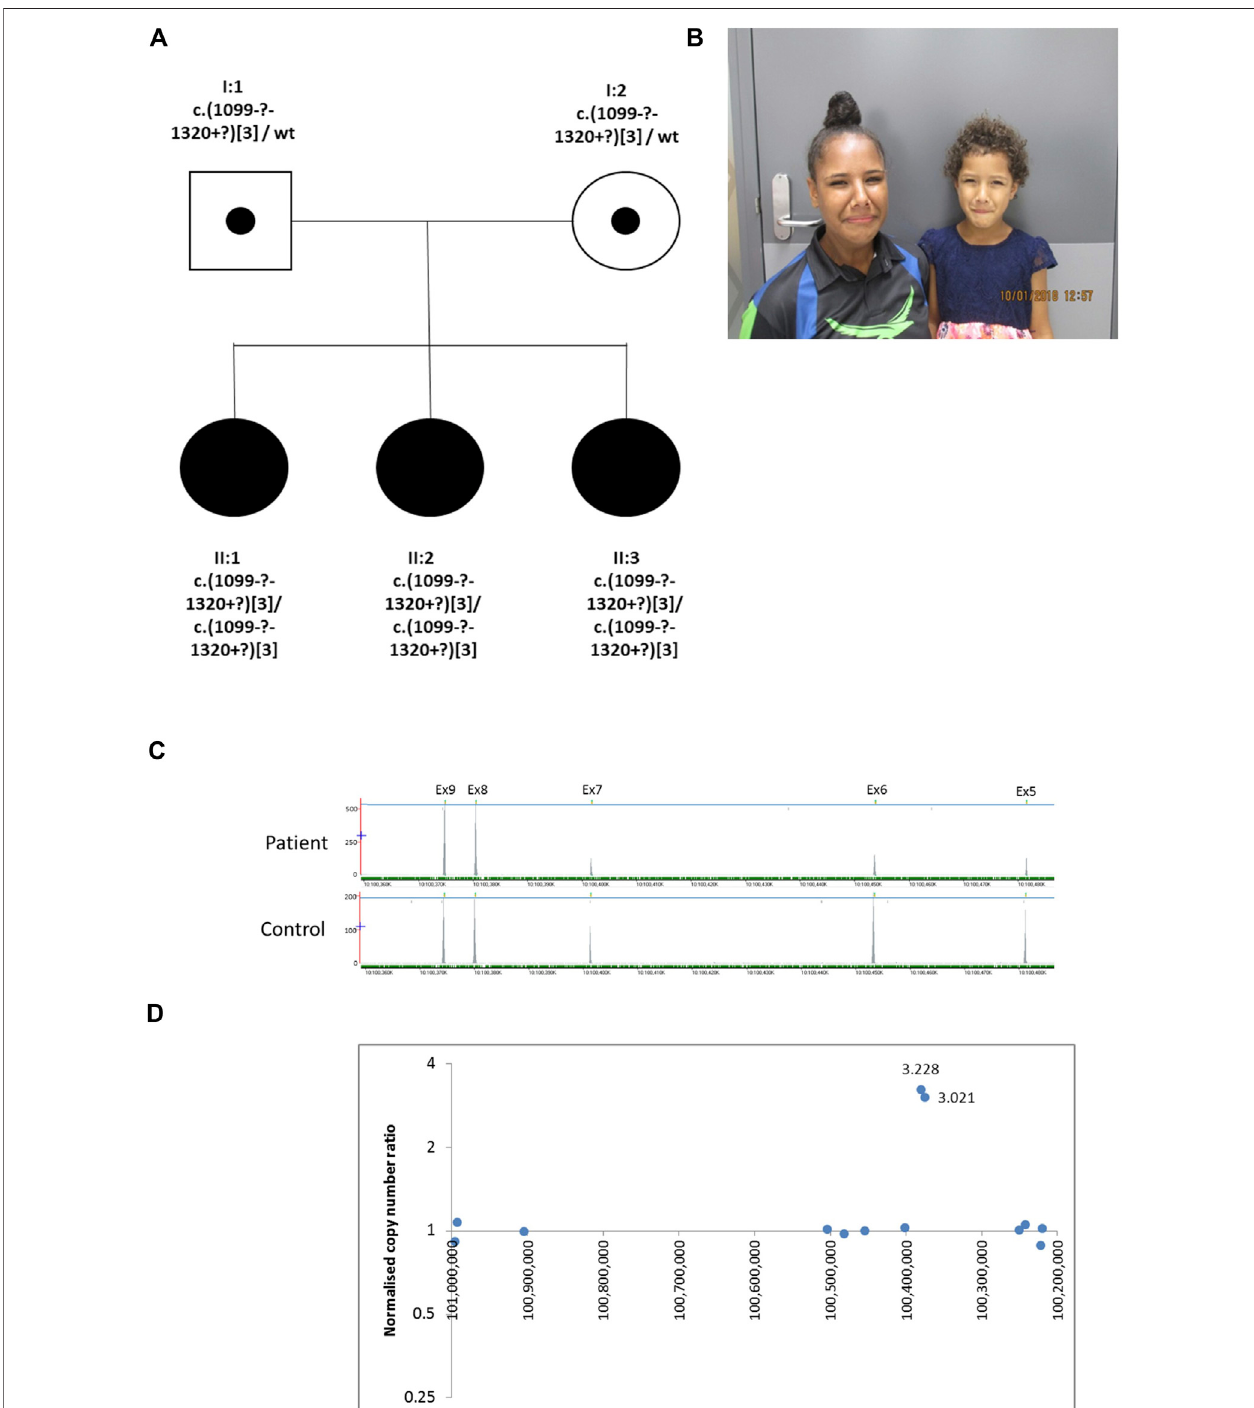
FIGURE 2 | Family 2. (A) . Pedigree of the Family 2 with three individuals affected with UFS (shaded). Dots represent clinically unaffected individuals con fi rmed to carrya HPSE2 heterozygousvariant (B) .GrimacewhensmilingcharacteristicofUFSinindividualsII:2andII:3. (C) .Y-axisindicatesrawdepthofcoverageafteralignment fromNGSgenepanel;X-axischromosomalcoordinatesinchr10(Notethat HPSE2 isontheminusstrand).Thebluelineindicatesthegene HPSE2 andthegreendashes the exons within HPSE2 Exon numbering according to NM_021828.4. (D) Copy number analysis in HPSE2 : Normalised copy number ratio of patient against sex- matchedcontrols.Datapointsforcapturedregionswithin HPSE2 .Y-axisshowsrelativecopynumberagainstcontrolsamples,where1indicateshavingnormaldiploidy; X-axis chromosomal coordinates on chromosome 10 in reverse orientation. Two consecutive exons in HPSE2 showed high normalised copy number ratio indicative of homozygous triplication (total of six